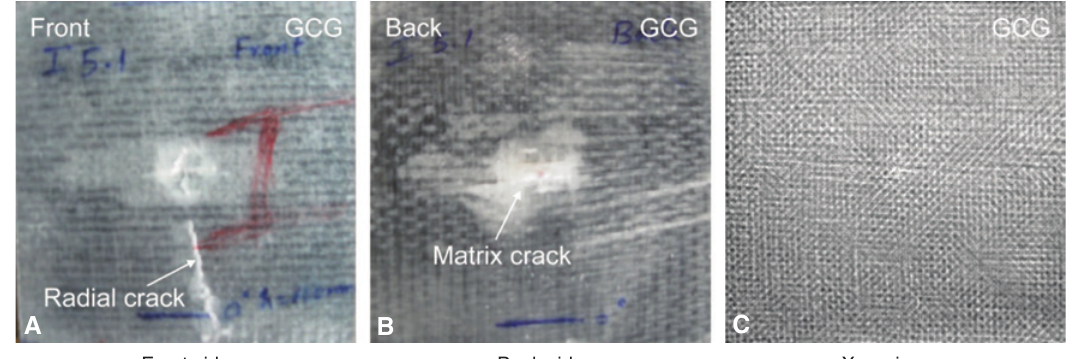
Figure 9: Photographs of impacted specimen GCG.